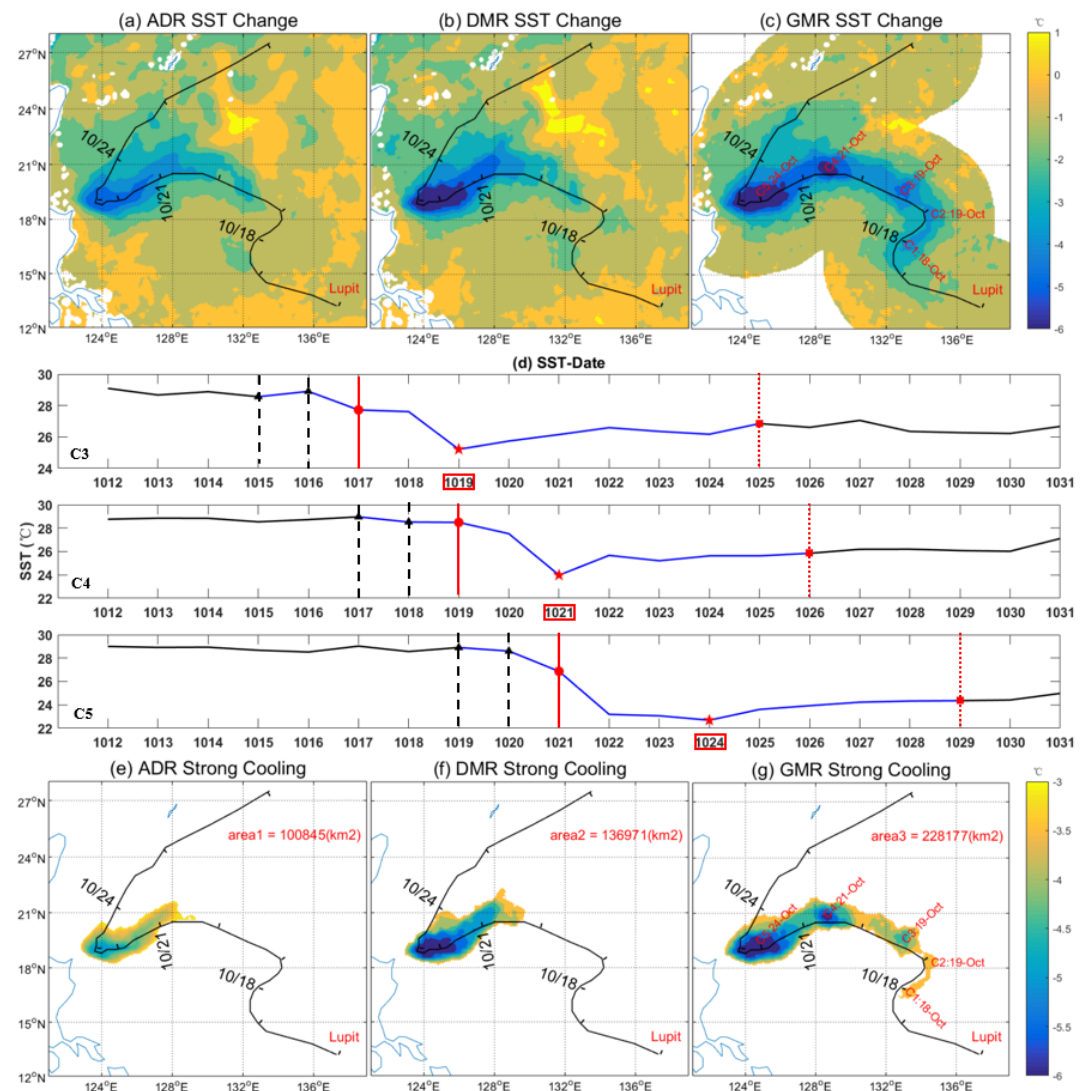
Figure 2. ( a – c ) SST response field, the cooling centers and their corresponding dates during the passage of Typhoon Lupit calculated by the ADR, DMR and GMR methods. ( d ) The evolution of SST at cooling centers C3, C4 and C5. The black dashed lines, the red solid lines and the red dashed lines represent the background, the initial forcing time and the end time of the SST response, respectively. The red stars and red boxes show the maximum SST cooling and its corresponding date. ( e – g ) The results of the ADR, DMR and GMR methods showing the areas of typhoon-included strong cooling during the passage of Typhoon Lupit.